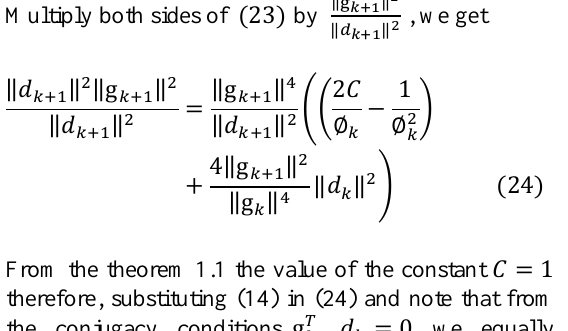
Table 1. Rate of Drug Abuse in Kano City for the